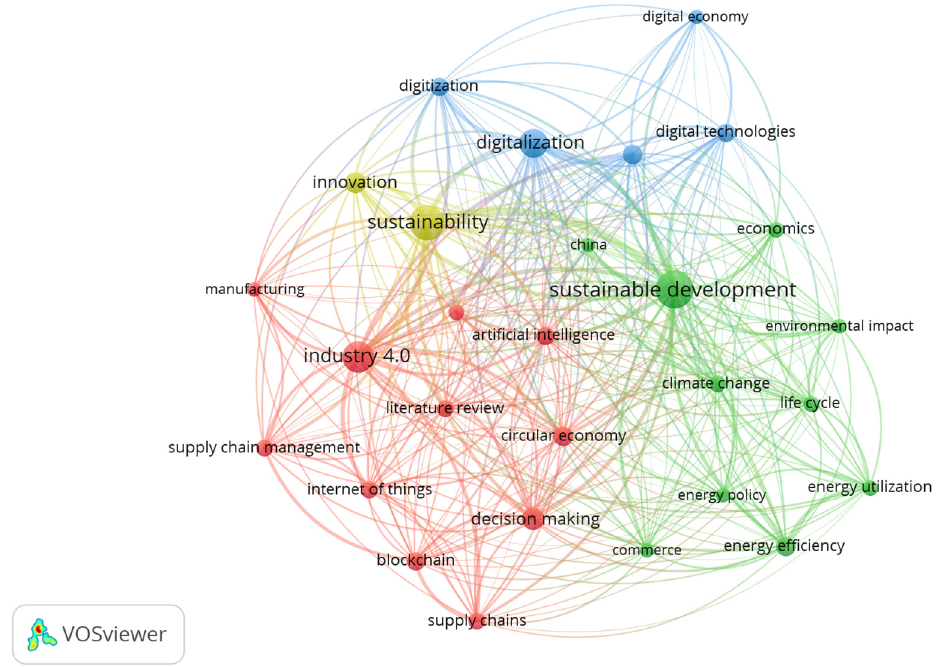
Table 2. The main clusters and topics description.